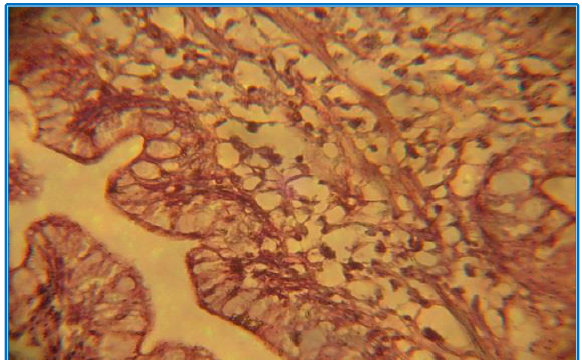
Figure, 2: Intestine of 1 st group after 120hrs. heat exposure shows marked lymphocytes proliferation in the submucosa (H and E stain 400X).